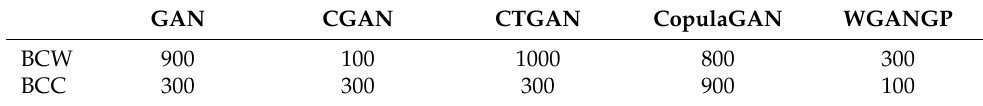
Table 1. Number of epochs for training GAN variants using two different datasets, BCW and